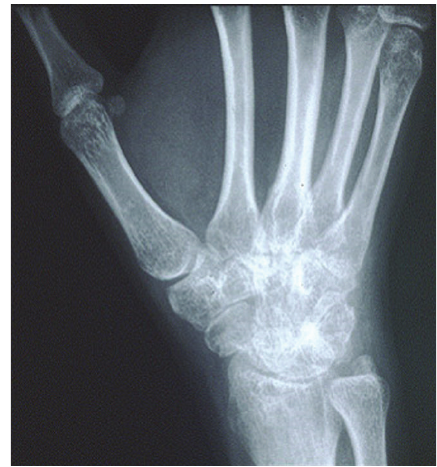
Figure 2: Xray of the right wrist showing diffuse narrowing of the radiocarpal and carpometacarpal joints of the wrist which is a characteristic finding in Still’s disease. (Source: http://www